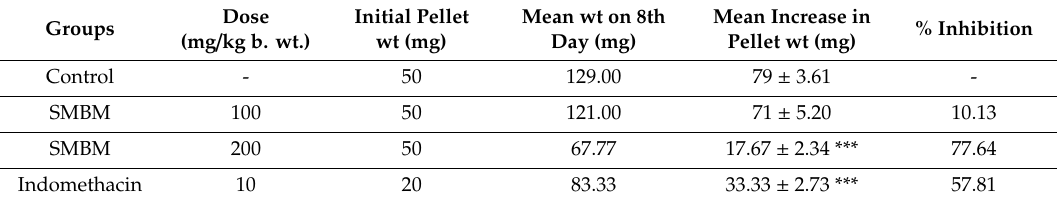
Table 5. Activity of SMBM against cotton pellet induced granuloma